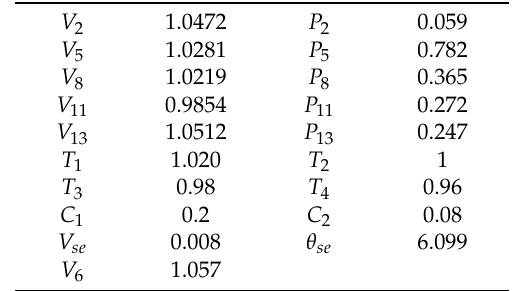
Table 5. The optimized system control parameters in Case A.